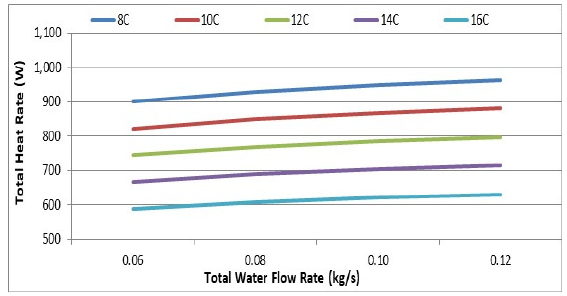
Fig. 5. The total heat rate of terminal units at 8, 10, 12, 14 and 16 °C water supply temperature and valve opening: Valve 1=100%, Valve 2=100% and Valve